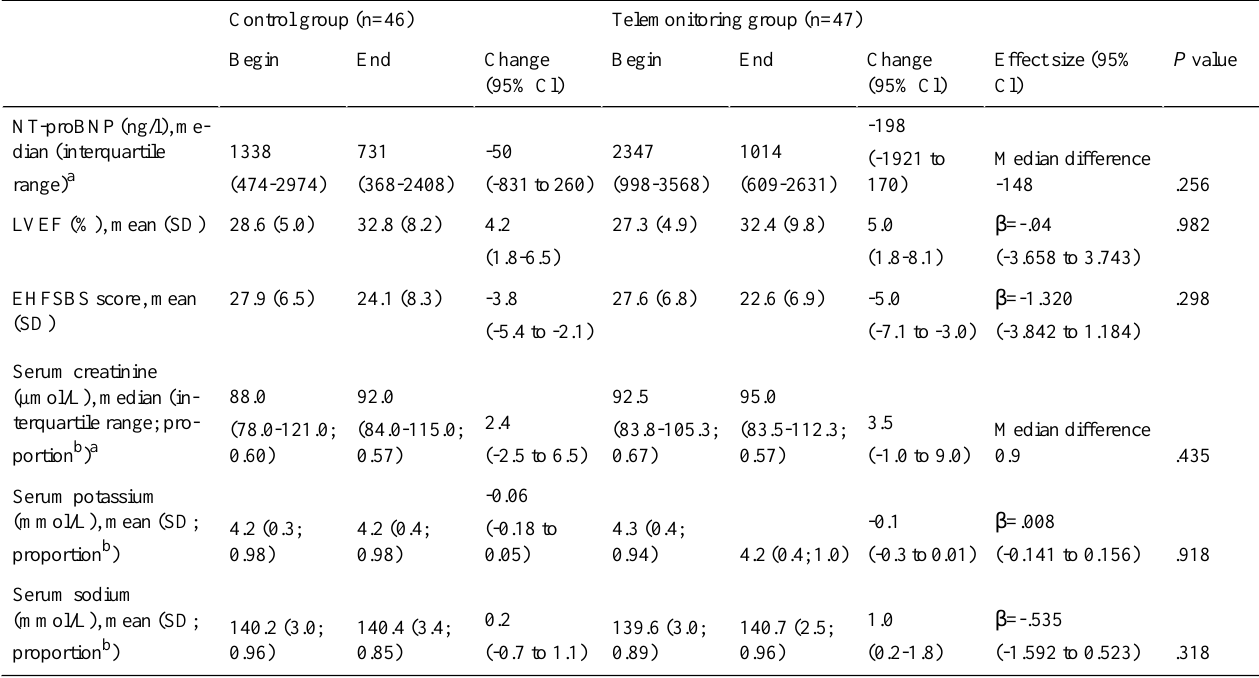
Table 2. Clinical outcomes at the beginning and the end of the study and the within-group change with the corresponding confidence intervals ( P value refers to the significance level for the between-group difference).